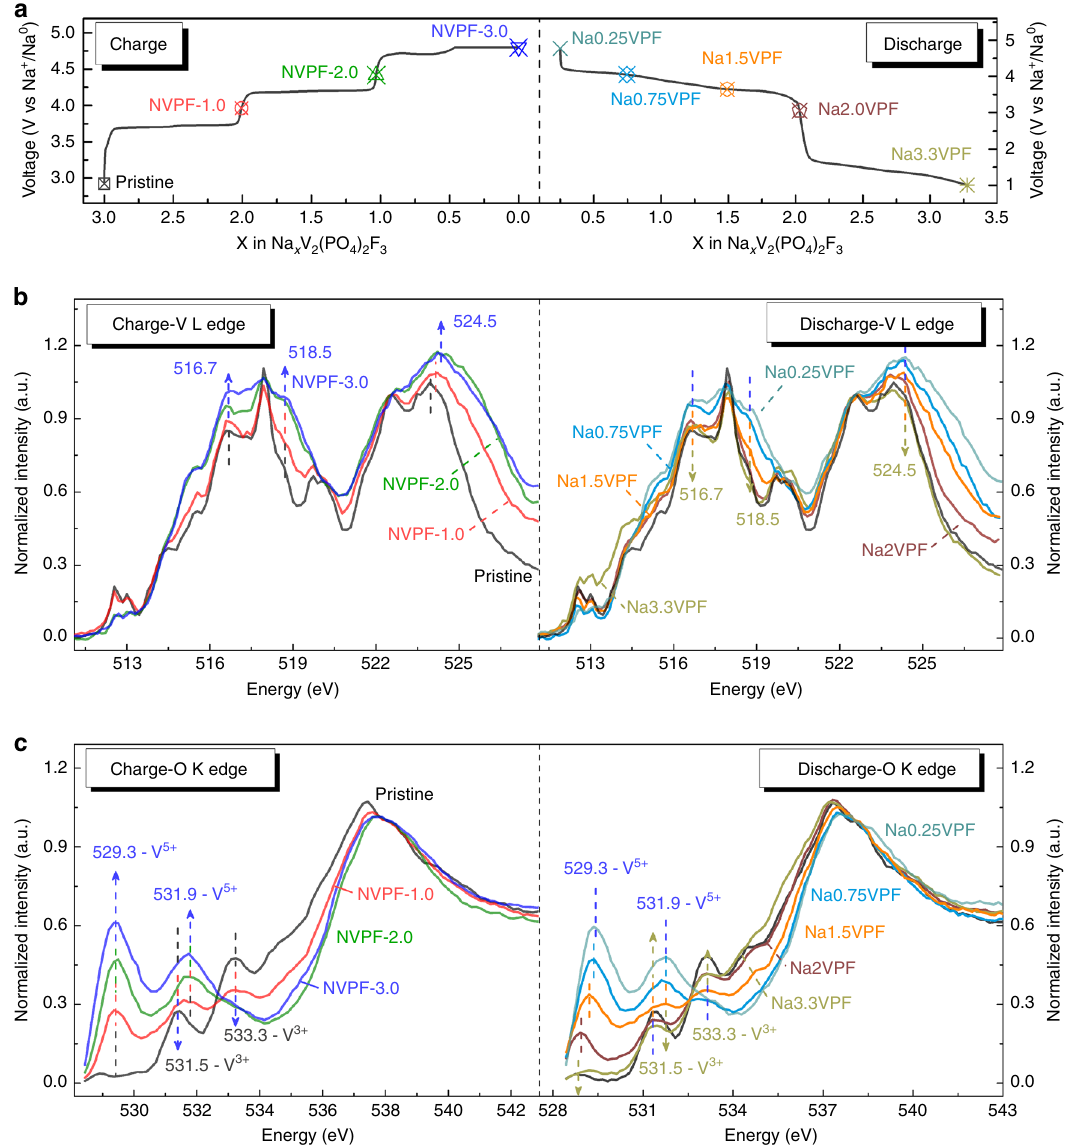
Fig. 7 Evolution of the vanadium oxidation state upon Na + extraction/insertion. a The voltage-composition curve of NVPF-3.0 sample cycled at C/10 in which the experimental points used for ex situ X-ray absorption analysis are marked with the respective Na-stoichiometry. The normalized ( b ) V L-edge and c O K-edge X-ray absorption spectra of the corresponding charge (left) and discharge (right) samples obtained in total fl uorescence yield